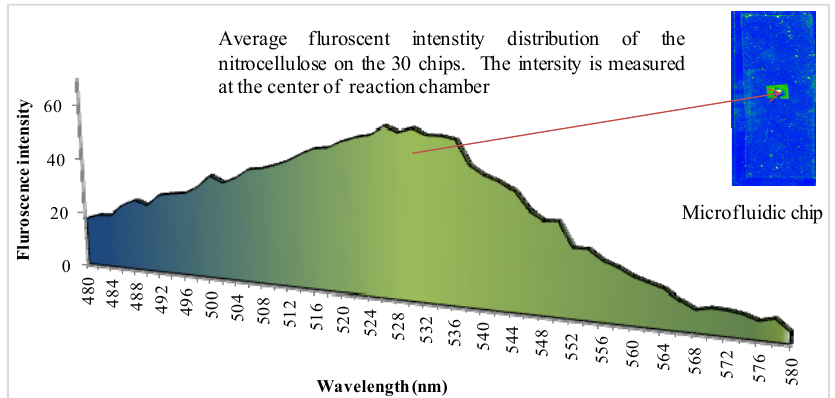
Figure 8. Fluorescent intensity on nitrocellulose vs .